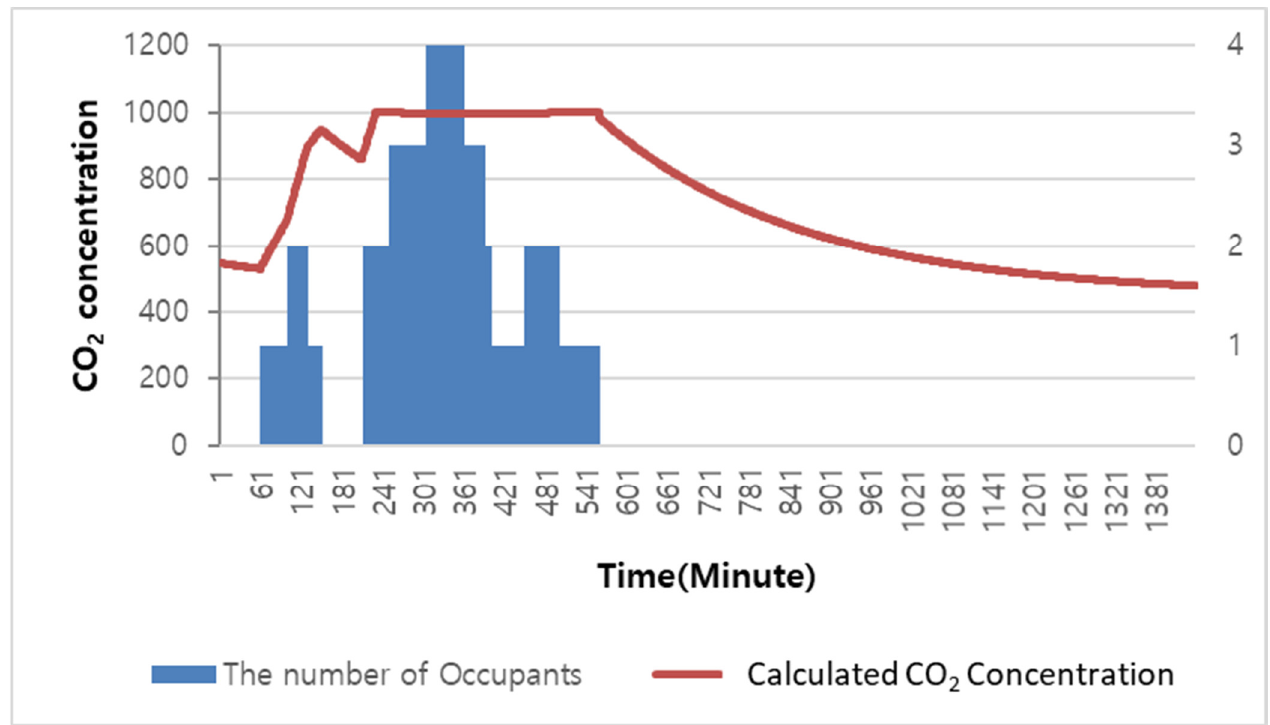
Figure 19. CO 2 concentration and the ventilation system